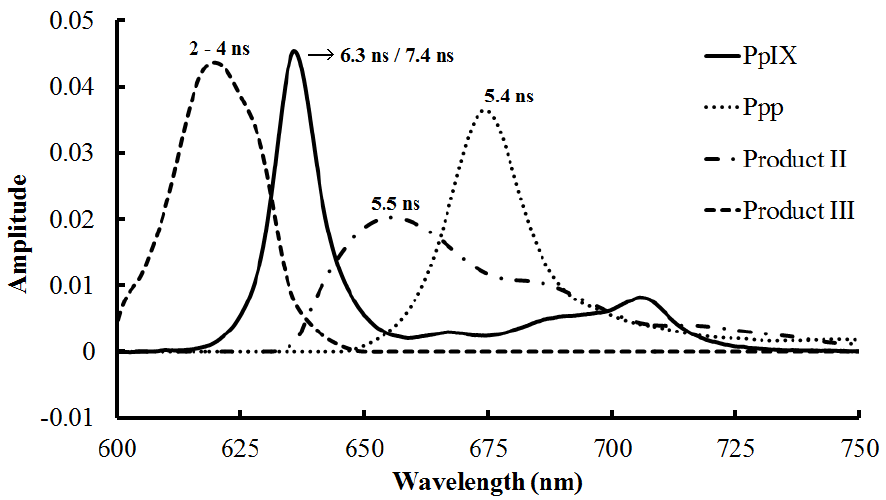
Figure 4 . The emission spectrum of 5-ALA-induced PpIX and its photoproducts. The monomer and photoproducts of the photosensitizers demonstrate significant spectral overlap. Fluorescence lifetimes of different 5-ALA metabolites in cells are also